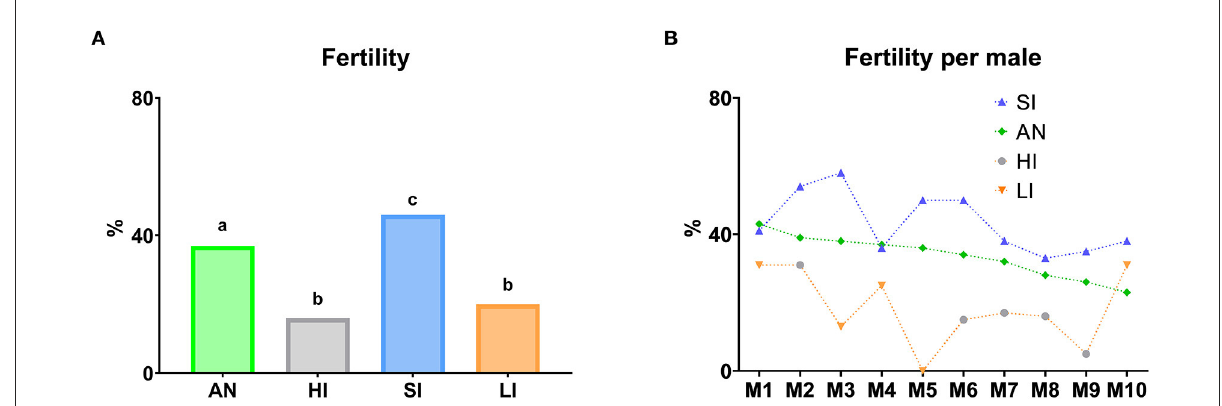
FIGURE12 Fertility according to different semen collection frequencies. (A) Fertility per group according to abstinence days before semen collection for AI. (B) Descriptive study of the fertility per male according to abstinence days before semen collection for AI. AN (Annual fertility), annual average of lambing ewes/inseminated ewes (%); HI (Fertility high interval), fertility with seminal doses obtained from males with at least 10 abstinence days; SI (Fertility standard interval), fertility with seminal doses obtained from males with two to five abstinence days; LI (Fertility low interval), fertility with seminal doses obtained from males with semen collection the previous day. In graphic (A) , different lowercase superscripts letters (a–c) indicate differences ( P ≤ 0.05) for each assessment point among semen collection ratios due to abstinence days before semen collection for AI. In graphic (B) , graph dots represent individual